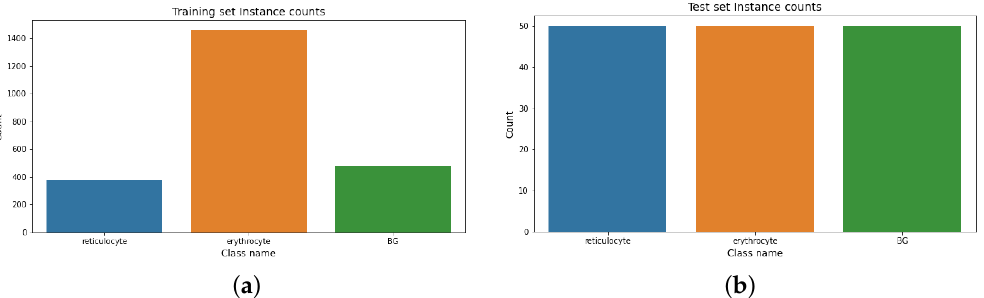
Figure 5. Instances count for the human reticulocyte dataset. ( a ) Training instance count for the human reticulocyte dataset. ( b ) Test instance count for the human reticulocyte dataset.